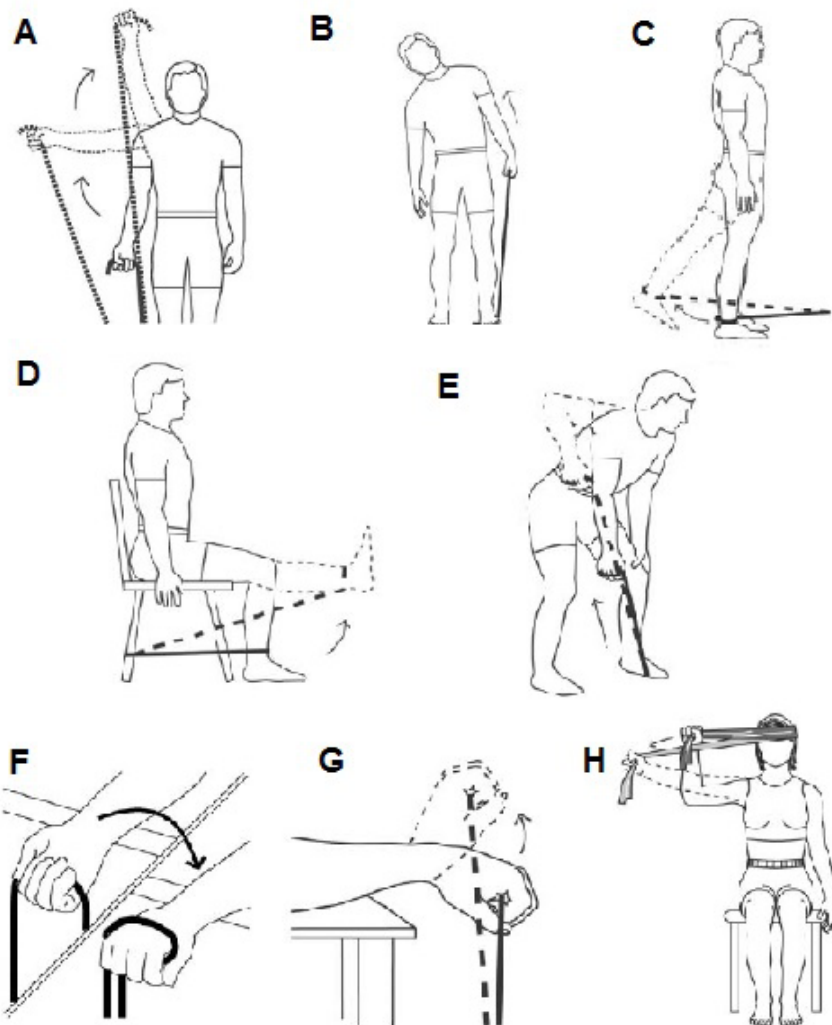
Figure 2. Representative exercises of SBP in AW and SW using resistance bands: shoulder (A), shoulder and trunk (B), hip (C), knee (D), elbow (E), wrist and forearm (F), fingers and wrist (G) and neck